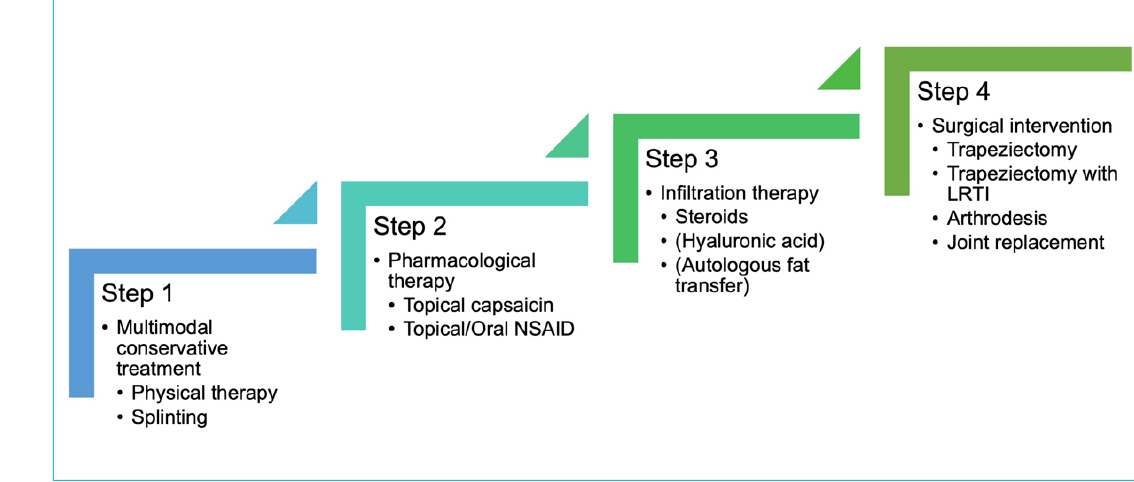
Figure 2: Treatment ladder for basal thumb osteoarthritis. A structured approach for all caregivers recommended by the department of hand surgery at Inselspital Bern, Switzerland. Different steps should be combined to ensure optimal treatment. If results are unsatisfactory for the patient, the treatment can be escalated to the next